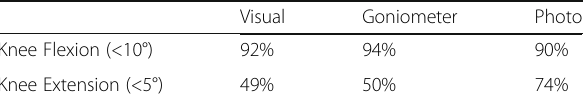
Table 4 Precision by technique for knee range of motion (proportions of measurement errors within 10° or 5° of motion capture